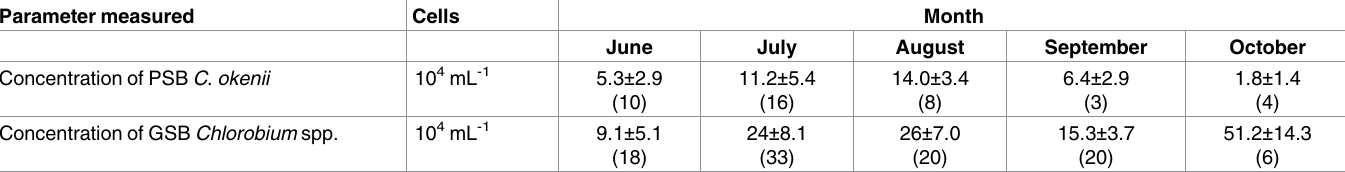
Table 2. Seasonal cell density for PSB C . okenii and GSB Chlorobium spp. in the chemocline of Lake Cadagno chemocline determined by FCM. Parameter measured Cells